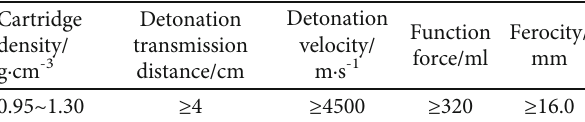
Table 2: Basic parameters of explosives.